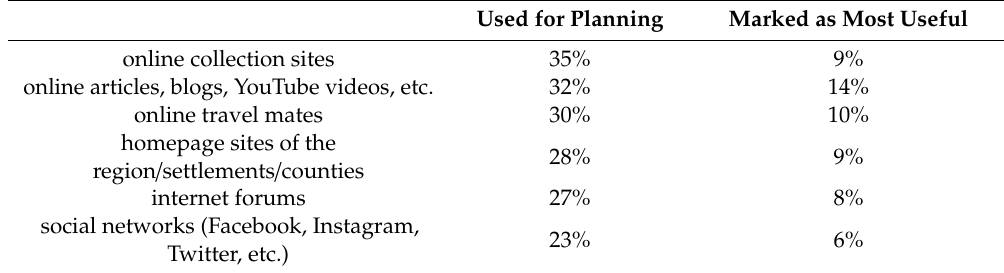
Table 14. Proportion of users of the most prevalent online tools with perceived usefulness. Used for Planning Marked as Most